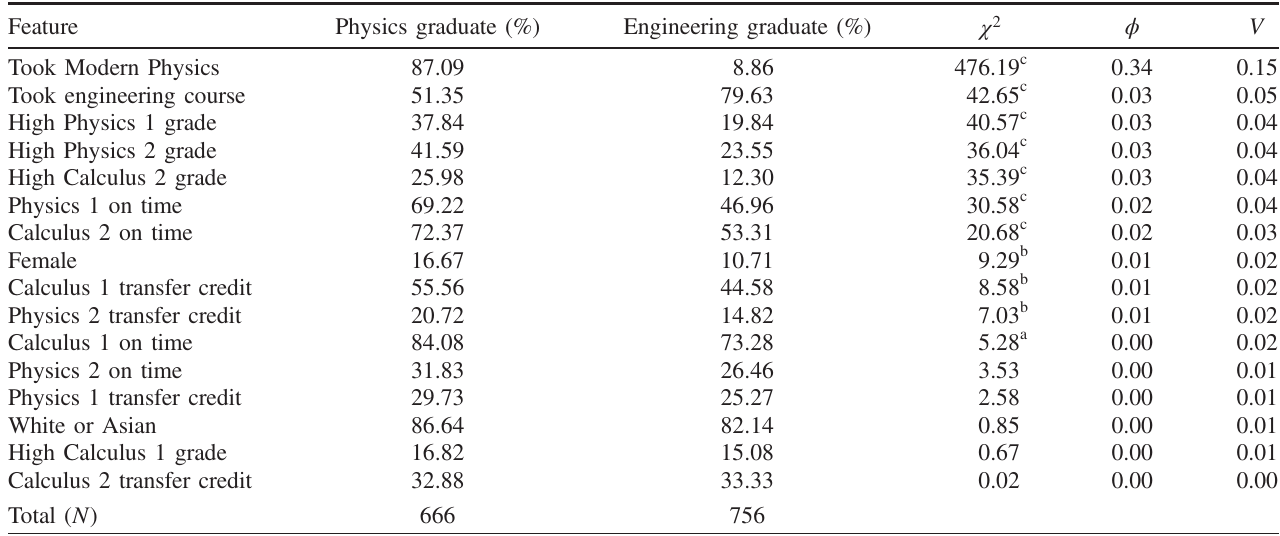
TABLE I. Summary statistics and contingency table analysis. The summary statistics are presented as percentages of the students who graduated with a degree (physics or engineering). Superscript “ a ” denotes p < 0 . 05 , “ b ” denotes p < 0 . 01 , and “ c ” denotes p < 0 . 001 .